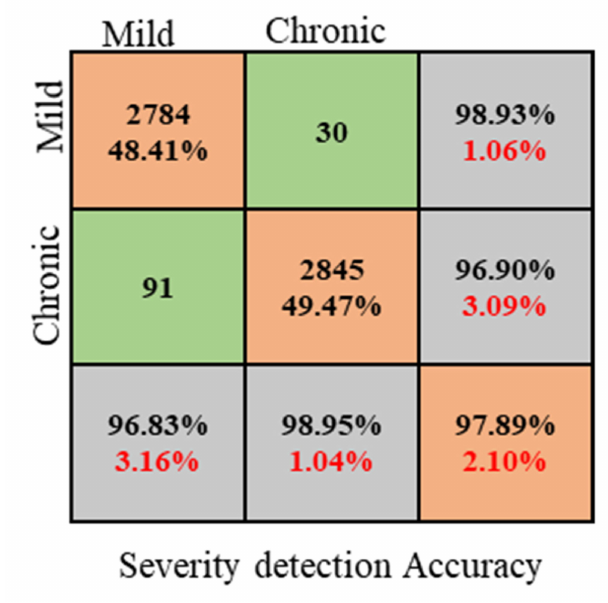
Figure 11. Confusion matrix of severity detection measures as Mild and Chronic during